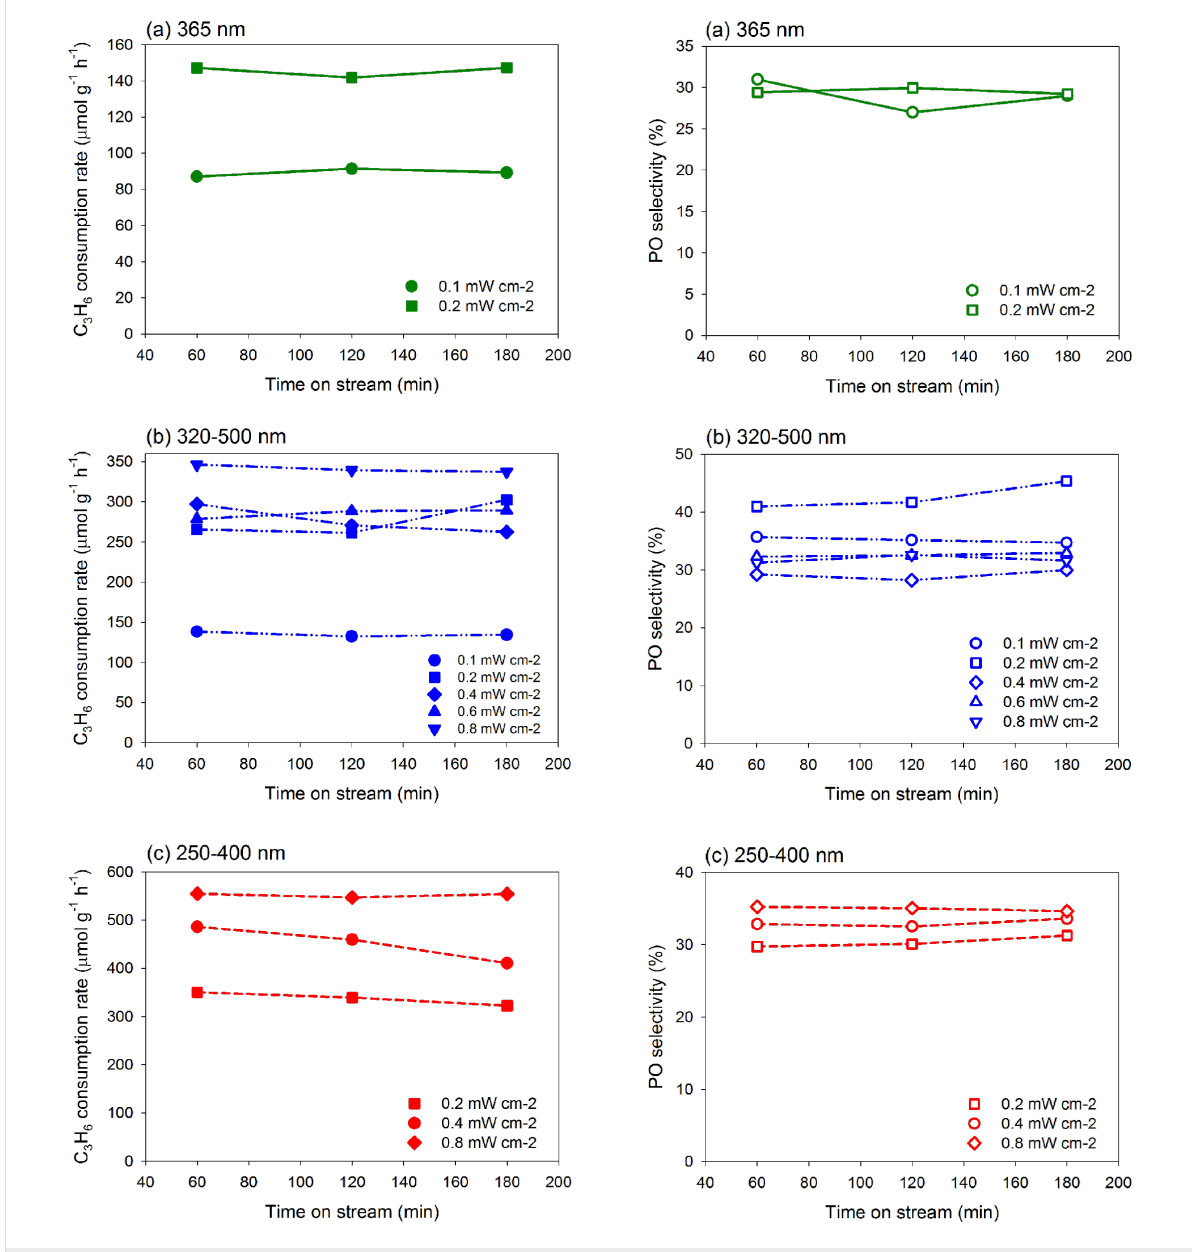
Figure 8: Time course of the photo-epoxidation of propylene with molecular oxygen under UV light for C 3 H 6 consumption rate and PO selectivity under different filters conditions: (a) 365 nm, (b) 320–500 nm and 250–400 nm.